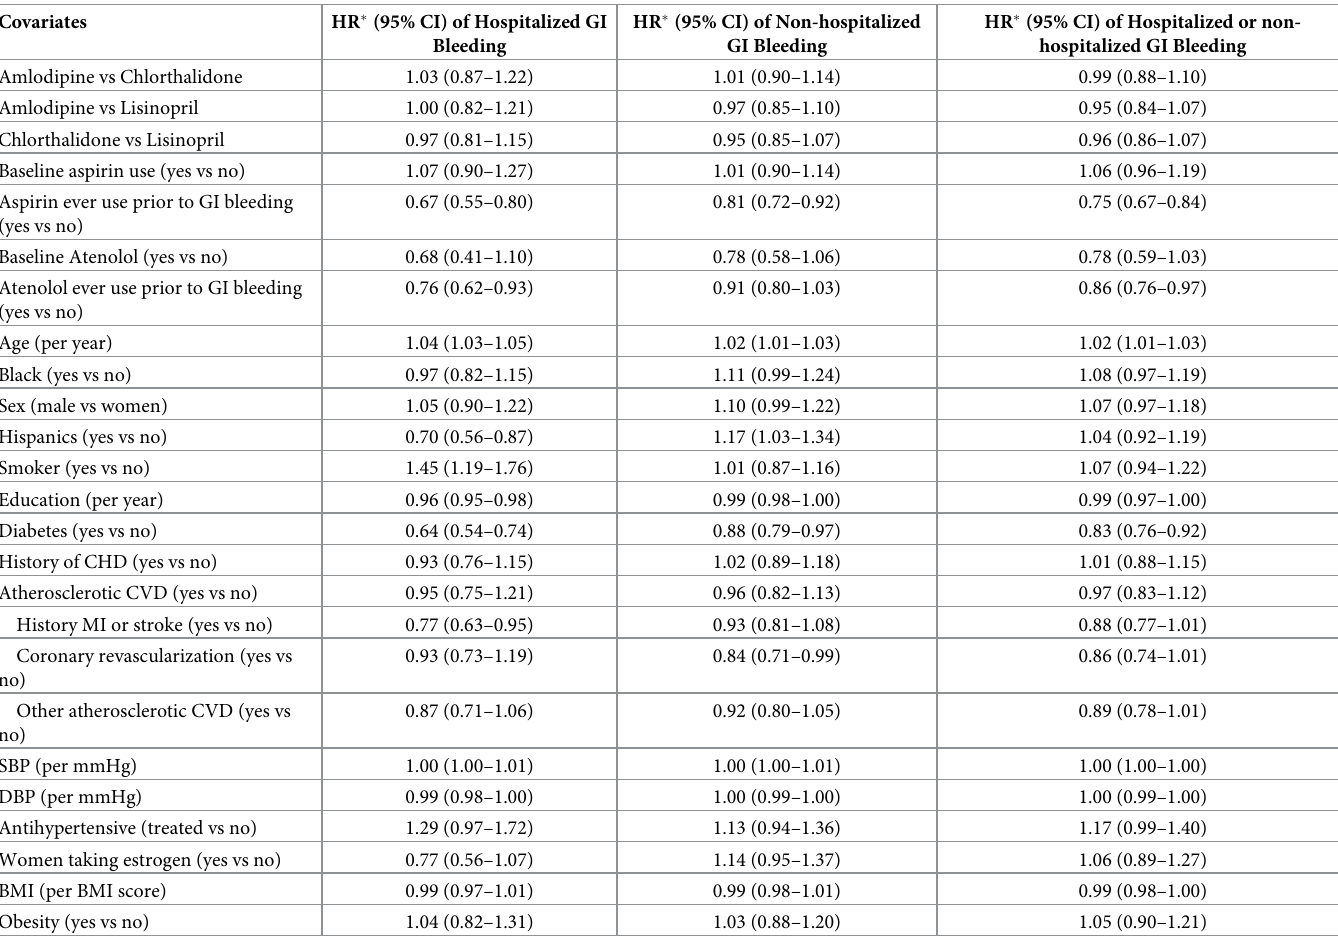
Table 5. The effect of antihypertensive treatment on the risk of hospitalized GI bleeding, non-hospitalized GI bleeding, and combined GI bleeding adjusting for baseline characteristics and in-trial use of aspirin and atenolol.